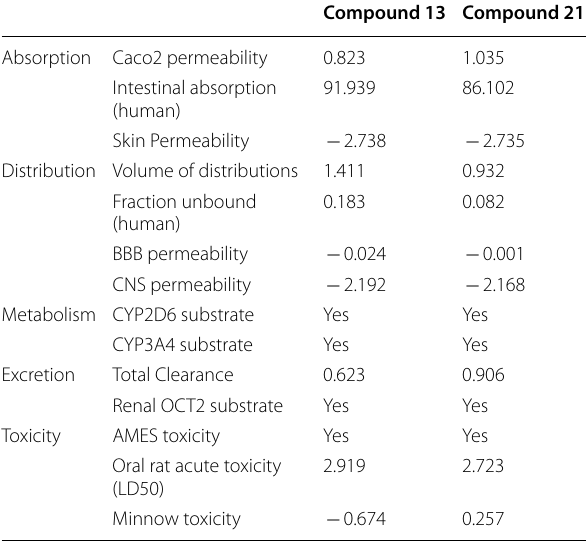
Table 9 Pharmacokinetics of compounds 13 and